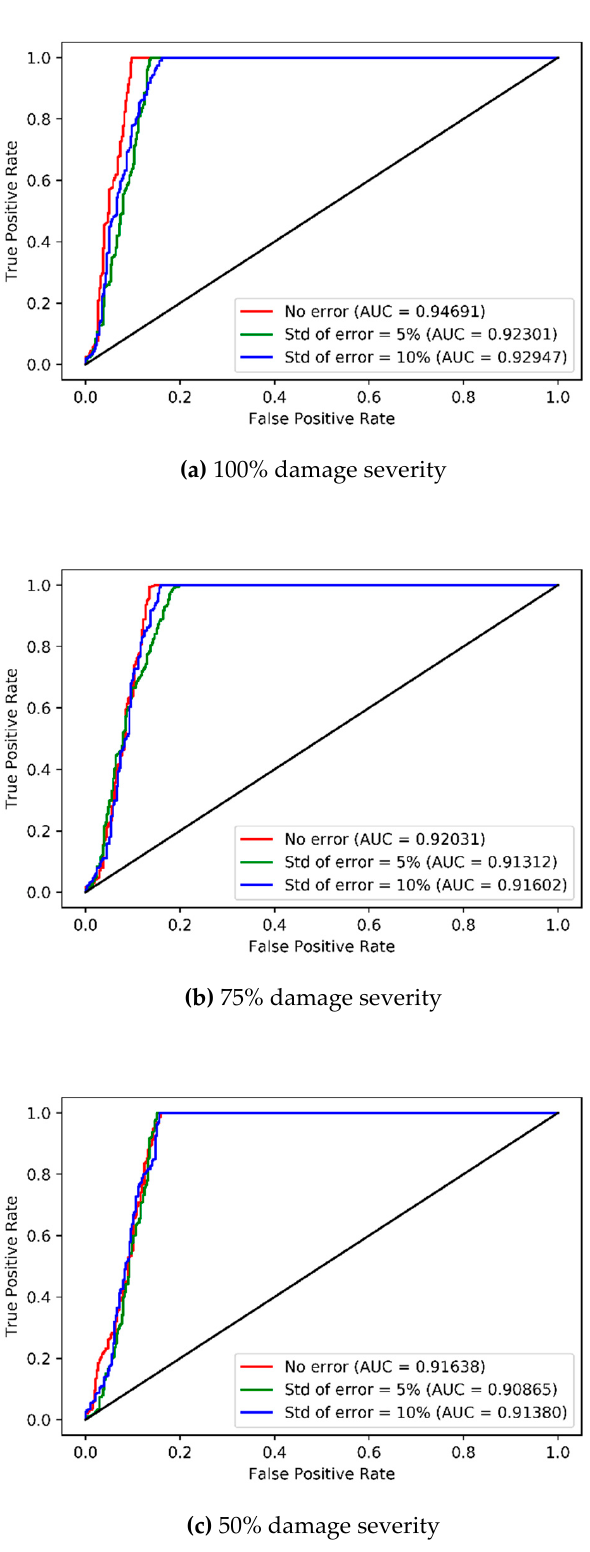
Figure 14. ROC curves and AUCs of CAE models corresponding to three levels of measurement errors